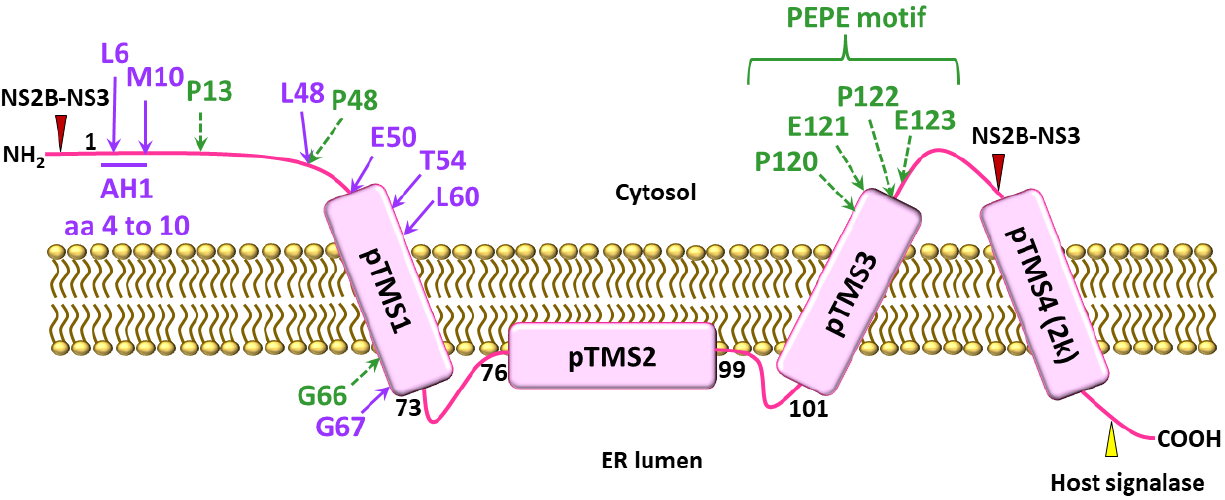
Figure 1. A membrane topology model of flavivirus NS4As. NS4A consists of an N-terminal cytosolic region and four predicted transmembrane segments: pTMS1, 2, 3 and 4 with the latter referred to as the 2k fragment. The red and yellow triangles mark the site of viral NS2B-NS3 protease and host signalase cleavage sites, respectively. Thick purple and dashed green arrows indicate specific amino acid (aa) residues in DENV and WNV NS4A, respectively, contributing to viral replication. AH1 is the experimentally determined amphipathic helix 1 of DENV NS4A. The position of critical amino acids is indicated.